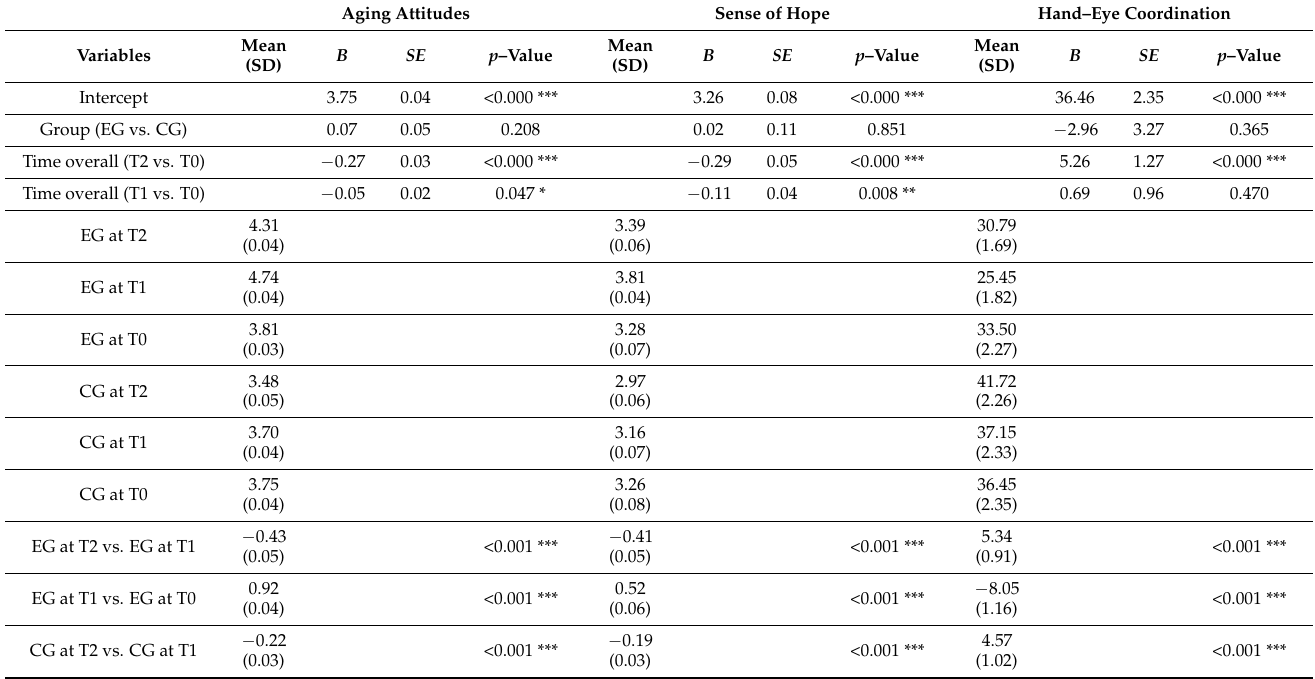
Table 6. Generalized estimating equation analysis results of attitudes toward aging in the experimental and control groups before and after the